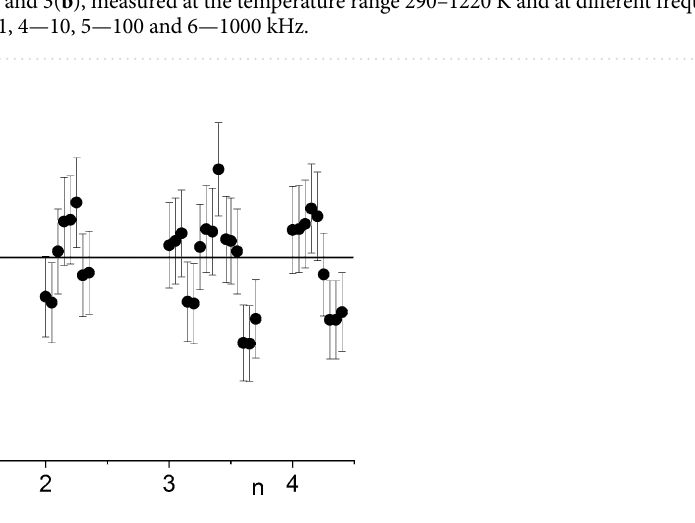
Figure 7. Temperature-frequency dependences of the dielectric permittivity (ε) and dielectric losses (tan δ) of samples of series 1( a ) and 3( b ), measured at the temperature range 290–1220 K and at different frequencies: